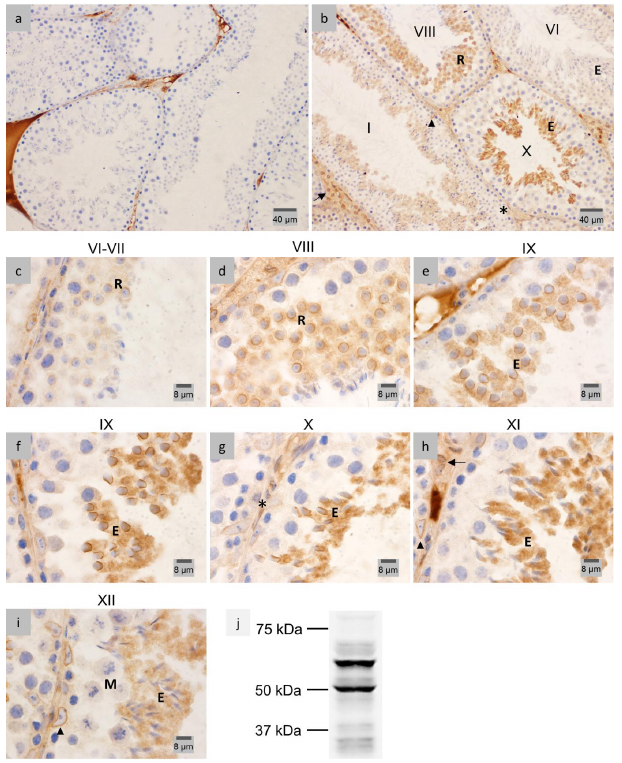
Figure 1. Immunohistochemical localization and expression of LAP1 in mouse testis sections fixed in diluted Bouin’s solution. Positive immunostaining appears in brown color and nucleus counterstaining with hematoxylin. ( a ) Negative controls with rabbit IgG showed LAP1 staining only in the interstitial tissue. ( b ) All epithelial stages were examined, of which stages I, VI, VIII and X (stages are indicated with Roman numerals) are depicted. LAP1 is present in the nuclear envelope (NE) of peritubular (asterisk), Leydig (arrow), and Sertoli (arrowhead) cells. LAP1 polarizes at one half of the NE in round spermatids (R) during stage VIII, then presents high positive staining in the cytoplasm of stage X elongating spermatids (E), which later show decreased cytoplasmic LAP1 staining in stage I. At the final stage of spermatogenesis, stage VI fully-elongated spermatids (E) apparently do not stain for LAP1. ( c ) During stages VI–VII, LAP1 is concentrated in the NE and less prominently in the cytoplasm of round spermatids (R). ( d ) In stage VIII, LAP1 signal polarizes at one half of the NE of round spermatids (R), with some cytoplasmic LAP1 staining being also observed. ( e ) Early and ( f ) late stage IX elongating spermatids (E) start displaying a shift in the nuclear direction towards the tubule lumen; simultaneously, LAP1 expression accentuates in one half of the NE and spreads to the cytoplasm. ( g ) In stage X, LAP1 still concentrates in one half of the NE of elongating spermatids (E), and its cytoplasmic presence is sustained. LAP1 staining is also observed in the NE of peritubular cells (asterisk). ( h ) Stage XI elongating spermatids (E) show a homogeneous distribution of LAP1 in the cytoplasm, contrasting with a decrease in the NE when compared to the previous stages. Sertoli (arrowhead) and Leydig (arrow) cells are also stained for LAP1. ( i ) In stage XII seminiferous tubules, with representative meiotic cells (M), LAP1 is located in the cytoplasm of elongated spermatids (E), although with less intense staining than in the prior stages. Sertoli cells (arrowhead) present LAP1 staining in the NE. ( j ) Expression of several LAP1 isoforms in mouse testis obtained by WB analysis. Essentially, two major bands are detected as previously described in [36]. One of the bands is below 75 kDa and presumably corresponds to both LAP1A and LAP1B, and the other one is above 50 kDa and corresponds to LAP1C; molecular masses in kDa are indicated on the left. LAP1: lamina-associated polypeptide 1; NE: nuclear envelope; WB: Western